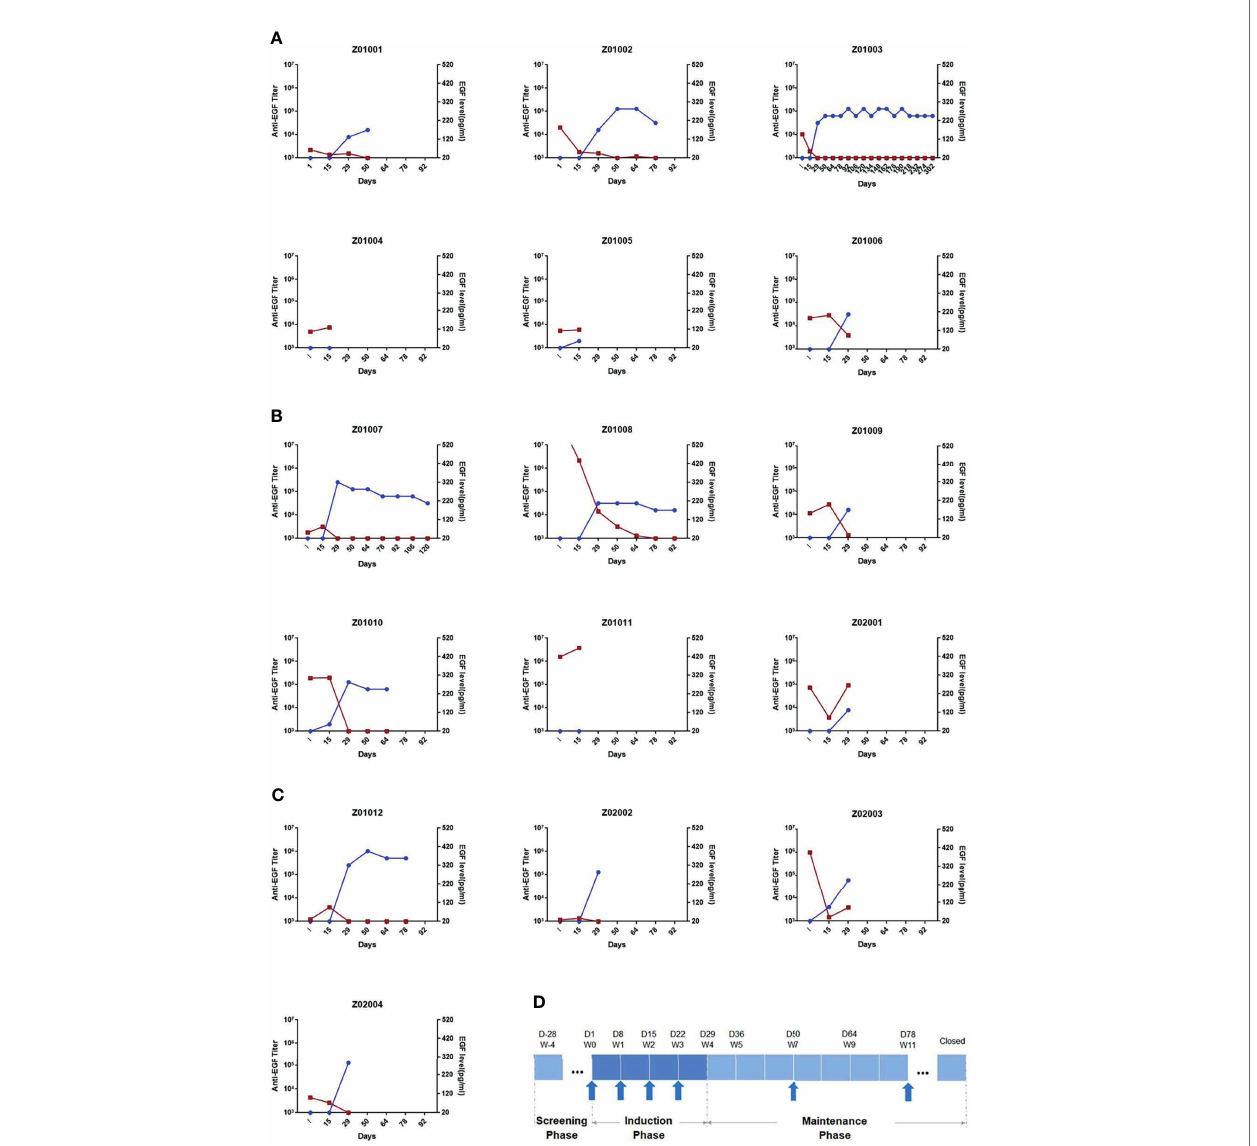
FIGURE 2 | The titers of anti-EGF antibody and the levels of EGF in serum in each subject receiving EGF- CRM197 treatment of 0.4mg (A) , 0.8mg (B) and 1.6mg (C) . (Blue: titers of anti-EGF antibody; Red: the levels of EGF in serum). (D) Study work fl ow and pro fi le of EGF-CRM197 vaccine